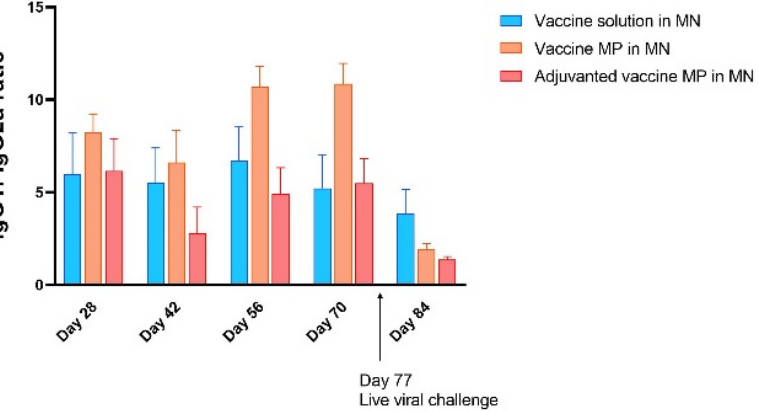
Figure 7. Calculation of IgG1:IgG2a ratio. A higher IgG1:IgG2a ratio in the group receiving vaccine MPs showed a Th2-oriented immune response after immunization, while a lower IgG1:IgG2a ratio in the group receiving adjuvanted vaccine MPs indicated a Th1-oriented immune response among the groups under consideration. After the live viral challenge, the ratio decreased further, indicating a shift towards a Th1-oriented immune response (data presented as mean ± SEM, n =